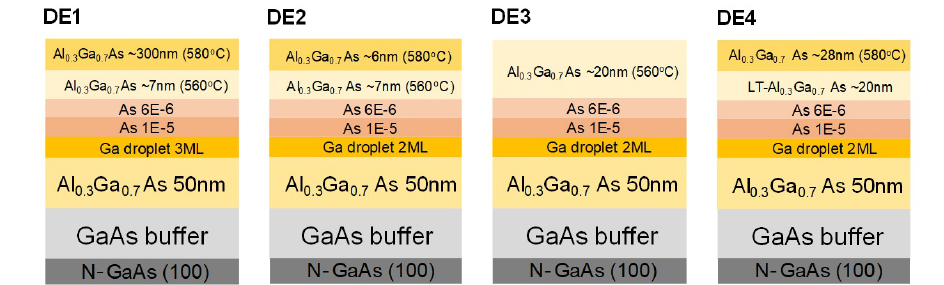
Figure 1. Schemat ics of layer structures and growth parameters in the four types of DE